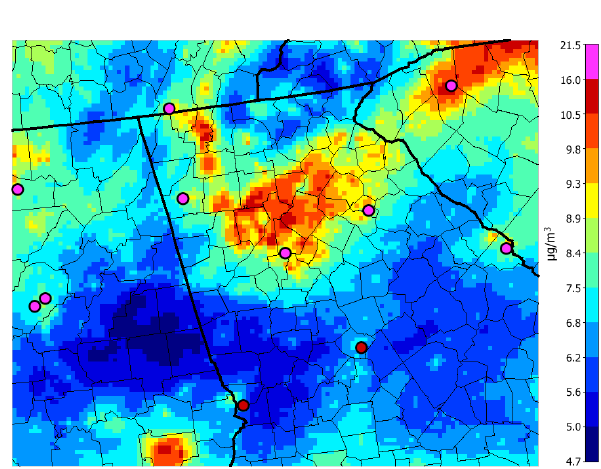
Fig. 2. Average modeled surface PM 2 . 5 concentrations in June and July 2002 in TC1 (base case). Circles show the location of the air quality monitors in the domain and share the same color scale as the underlying tile